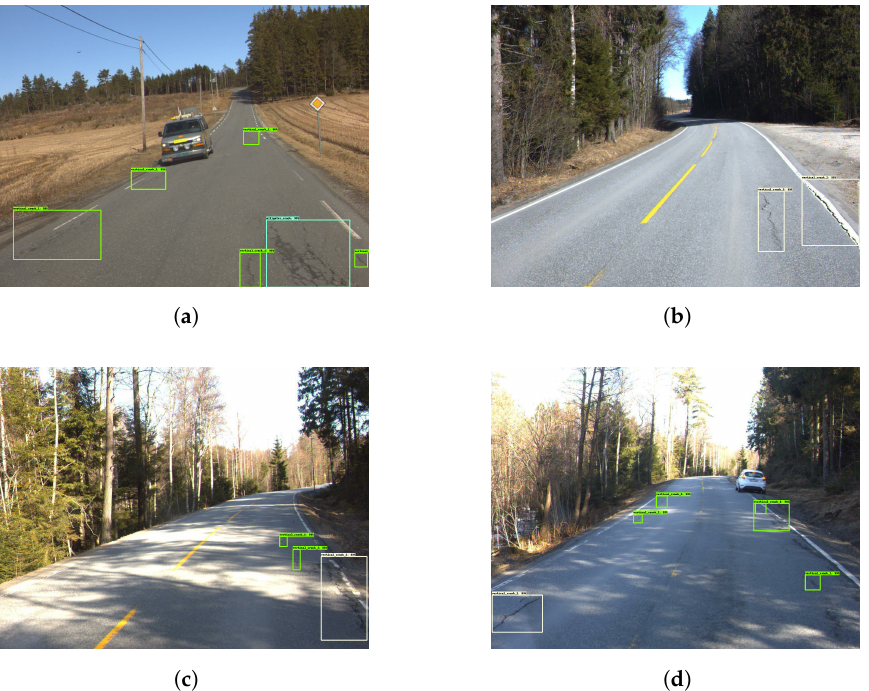
Figure 9. Good damage detection. The green and yellow boxes represent the vertical cracks while cyan colored boxes are the horizontal